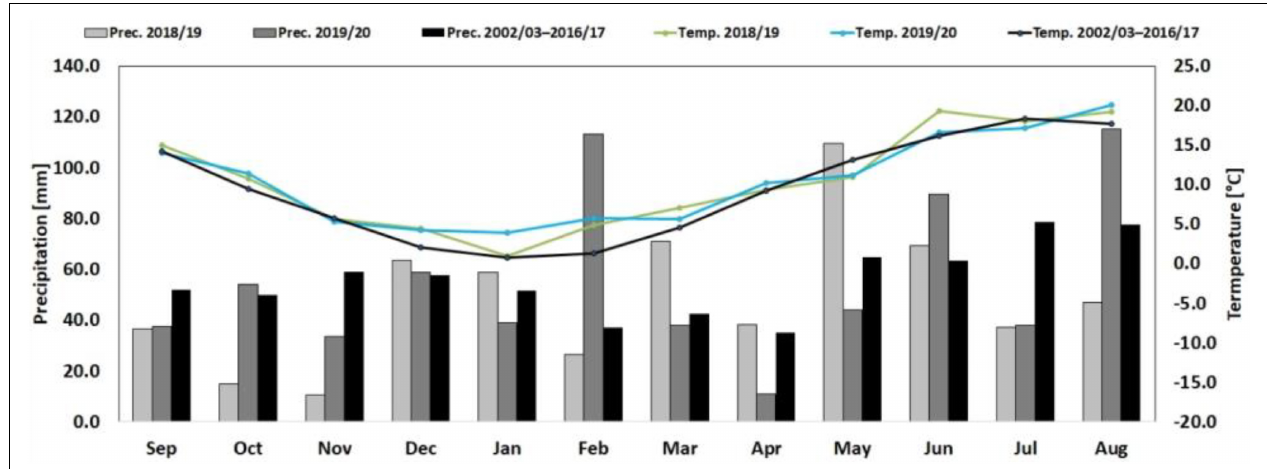
FIGURE 1 | Monthly mean precipitation and temperature for two experimental seasons and the long-term means (2002/2003–2016/17). Weather data were obtained from the weather station located in the research station.